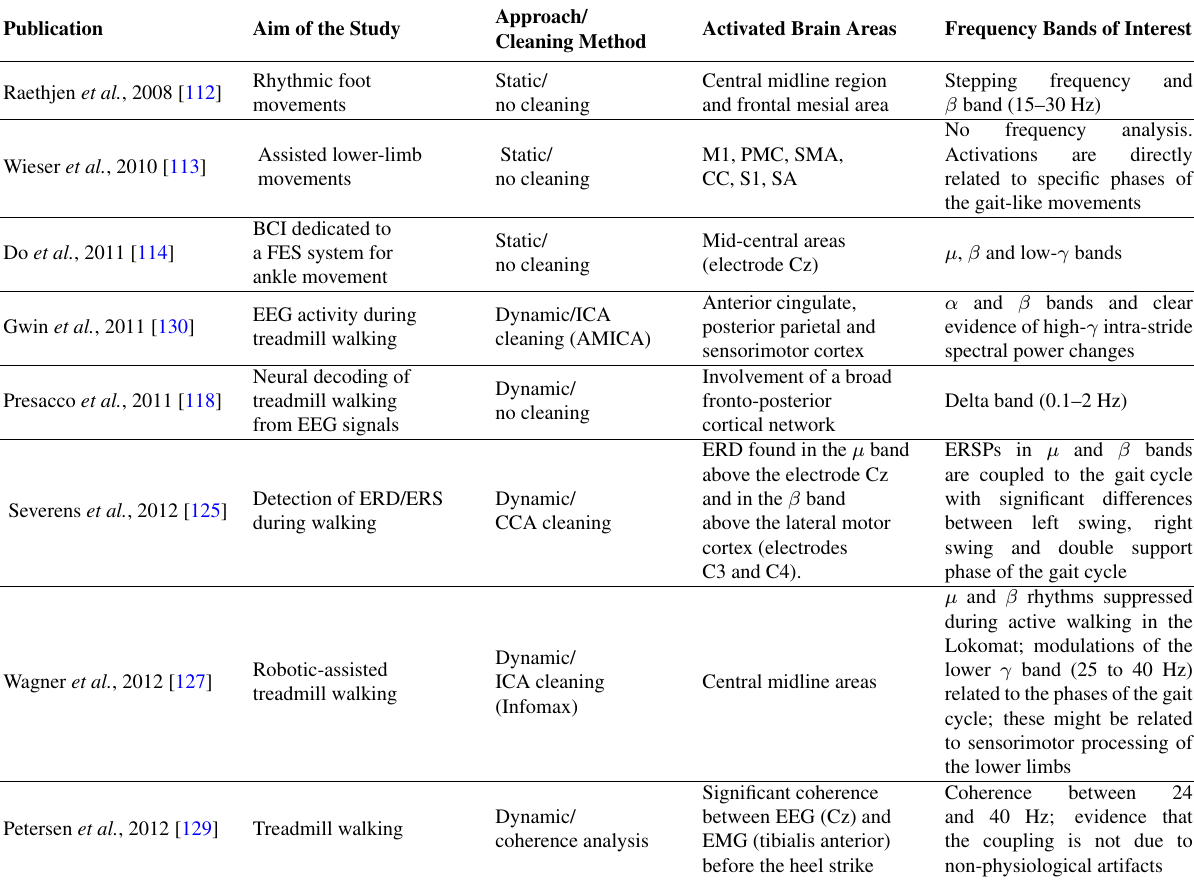
EEG studies of human locomotion: a schematic view of recent